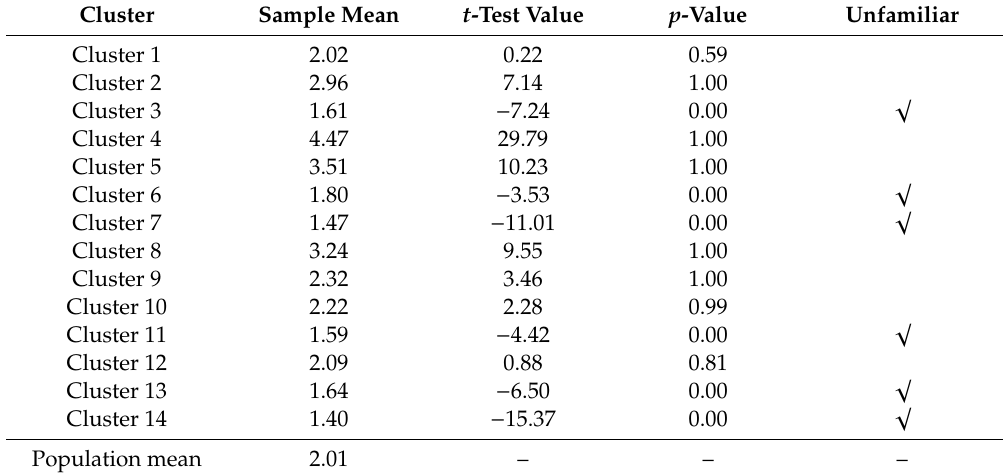
Table 4. Japanese unfamiliar city